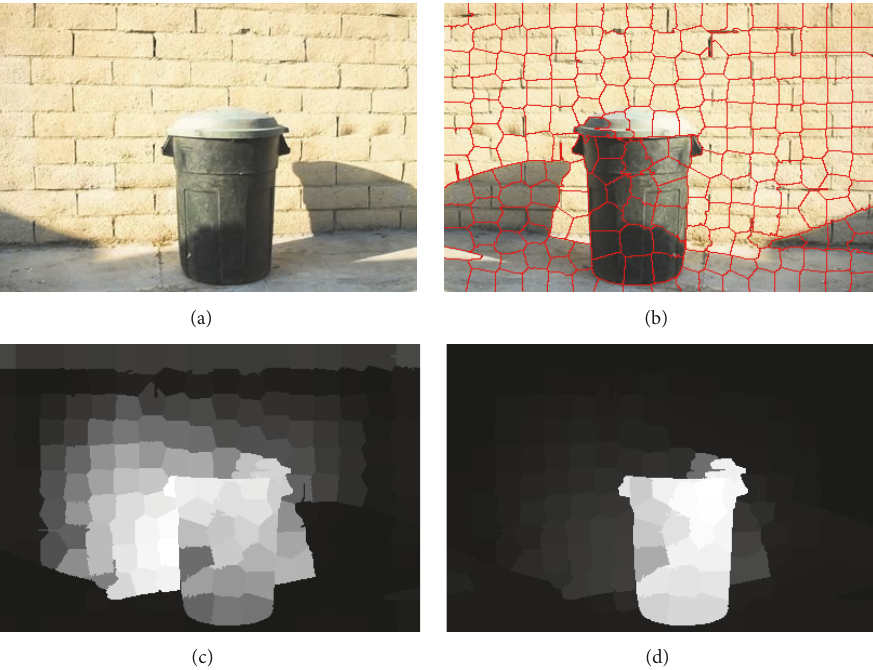
Figure 2: Diagram of the main step in the salient object detection model: (a) original image, (b) superpixels, (c) saliency map in the first stage, and (d) final saliency